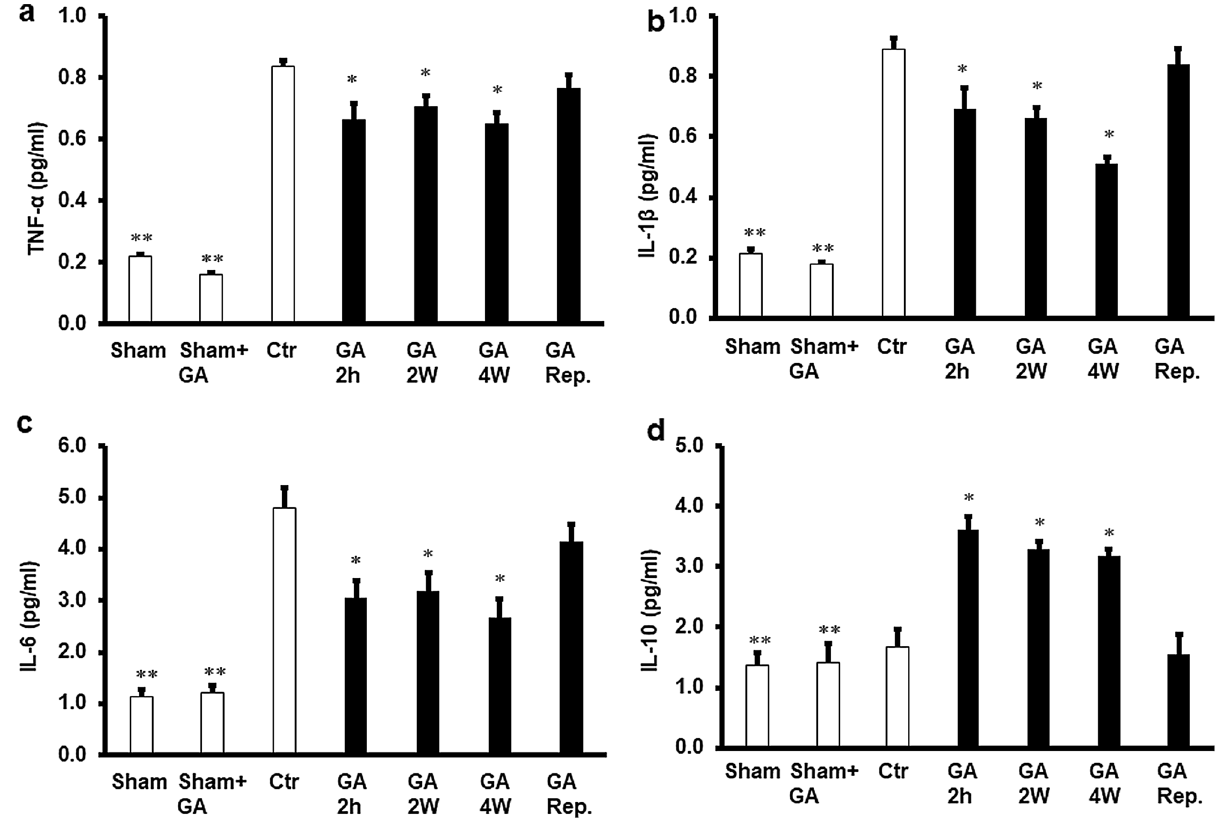
Figure 4. Pro-inflammatory and anti-inflammatory cytokine levels in the cardiac muscle samples after GA for 2 weeks, 4 weeks, or 2 h before sacrifice or at reperfusion compared to those in the control group (n = 4). GA decreased the TNF-α protein levels ( a ), IL-1 protein levels ( b ), the IL-6 protein levels ( c ) and had no effect on the anti-inflammatory cytokine IL-10 ( d ) protein levels. Ctr control, GA 2 h Gum Arabic infusion 2 h before sacrifice, GA 2 W Gum Arabic administration for 2 weeks, GA 4 W Gum Arabic administration for 4 weeks, GA Rep . Gum Arabic infusion at reperfusion. *P < 0.05 compared to the respective controls and **P < 0.01 compared to controls and other